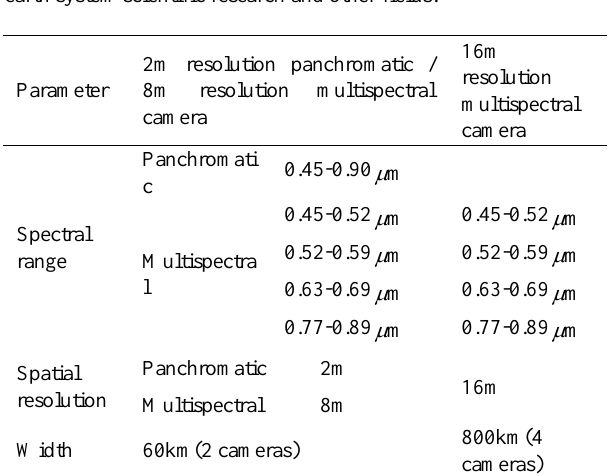
Table 3 . Technical index of GF1 satellite